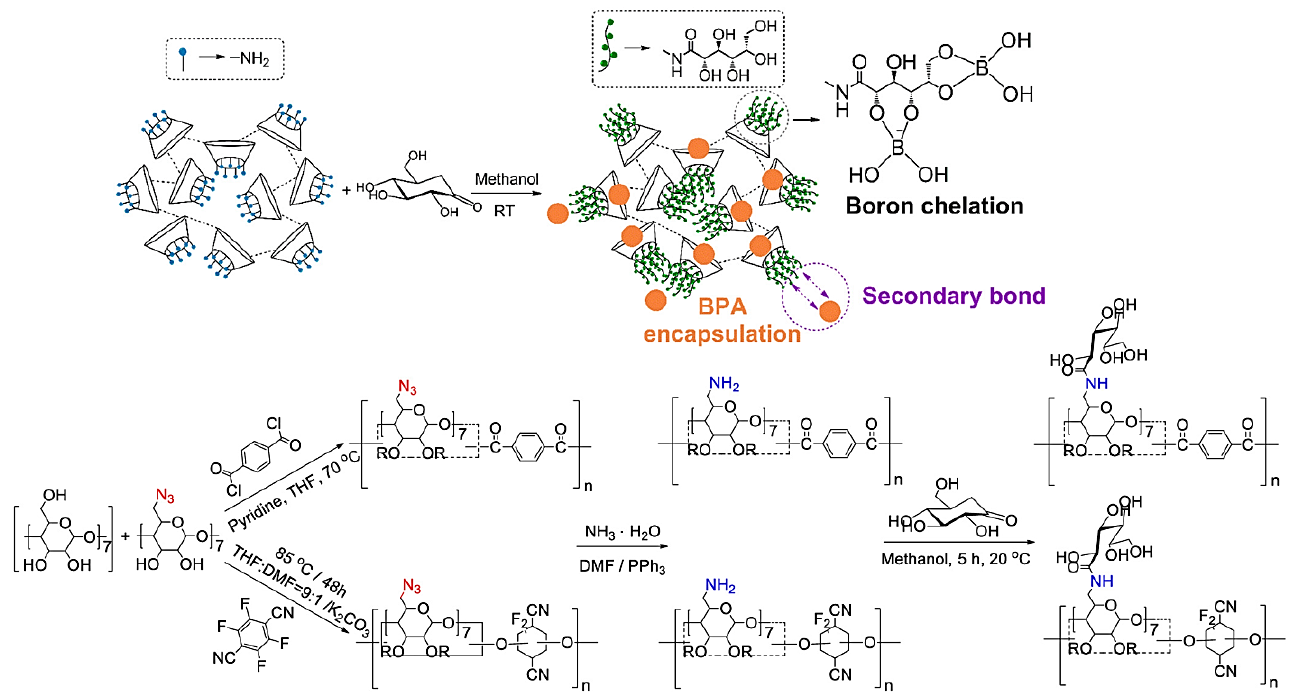
Figure 2. The preparative process for mesoporous cyclodextrin polymers using a copper-free syn- thesis technique and functionalization of polyols immobilized on their surfaces. Adapted with per- mission from Ref. [46], Copyright 2019, American Chemical Society.